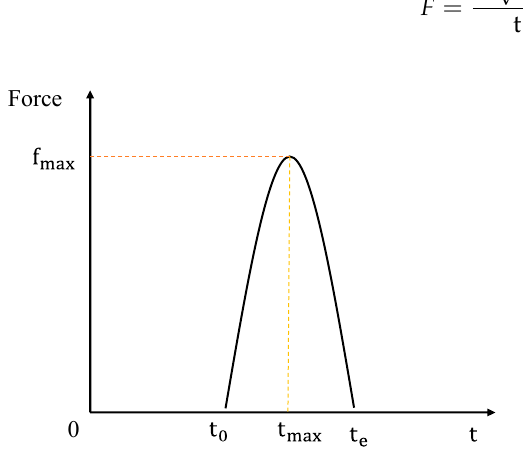
Figure 2. Shock history of positive half cycle